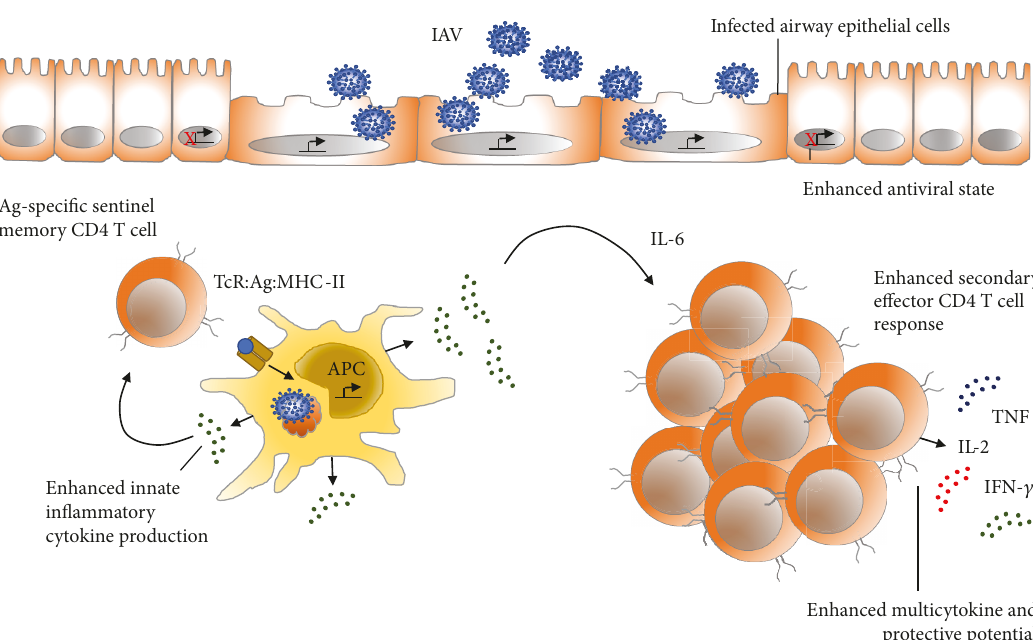
Figure 2: Memory T cells regulate the accumulation and functional potential of secondary e ff ector T cells in the lung through antigen-speci fi c upregulation of the in fl ammatory cytokine IL-6. Following secondary IAV infection, the earlier and more robust in fl ammatory response induced by memory CD4 T cells correlates with improved control of the virus in the lung. One innate in fl ammatory cytokine involved in this response, IL-6, plays a central role in maximizing the multicytokine-producing potential of secondary CD4 + T e ff ector cells that accumulate in the lung at the peak of the recall response. Experienced memory cells thus modulate the e ff ector functions of recently expanded secondary e ff ector T cells that arise from resting memory T cell precursors during recall responses by inducing potent in fl ammatory